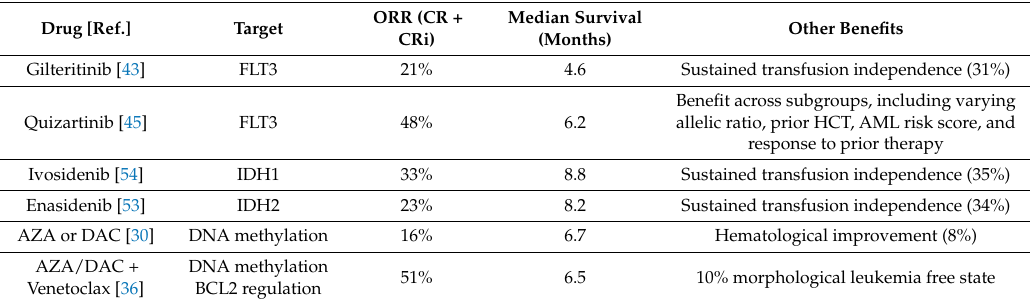
Table 1. Molecular targets and results of recently approved new drugs for the treatment of relapsed elderly patients with AML. AZA: azacytidine; CR: complete remission; CRi: CR with incomplete hematological recovery; DAC: decitabine.; ORR: overall response rate; HCT: hemopoietic cell transplantation.